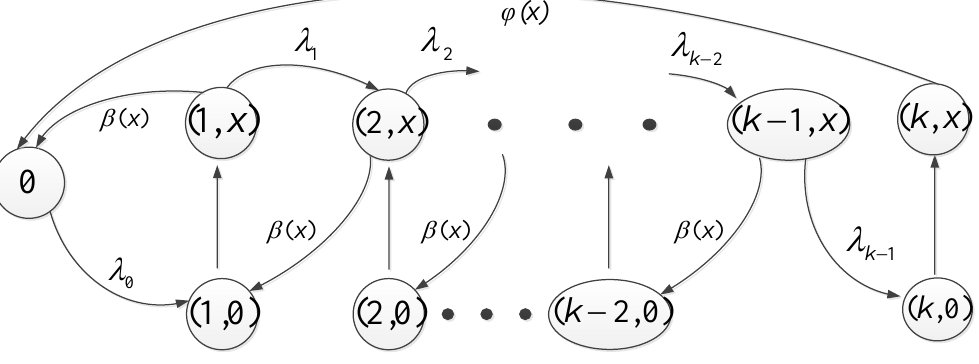
Figure 2. Transition graph of the process Z ( t ) , which described the behavior of a k -out-of- n model. Based on the presented transition graph and using the description of